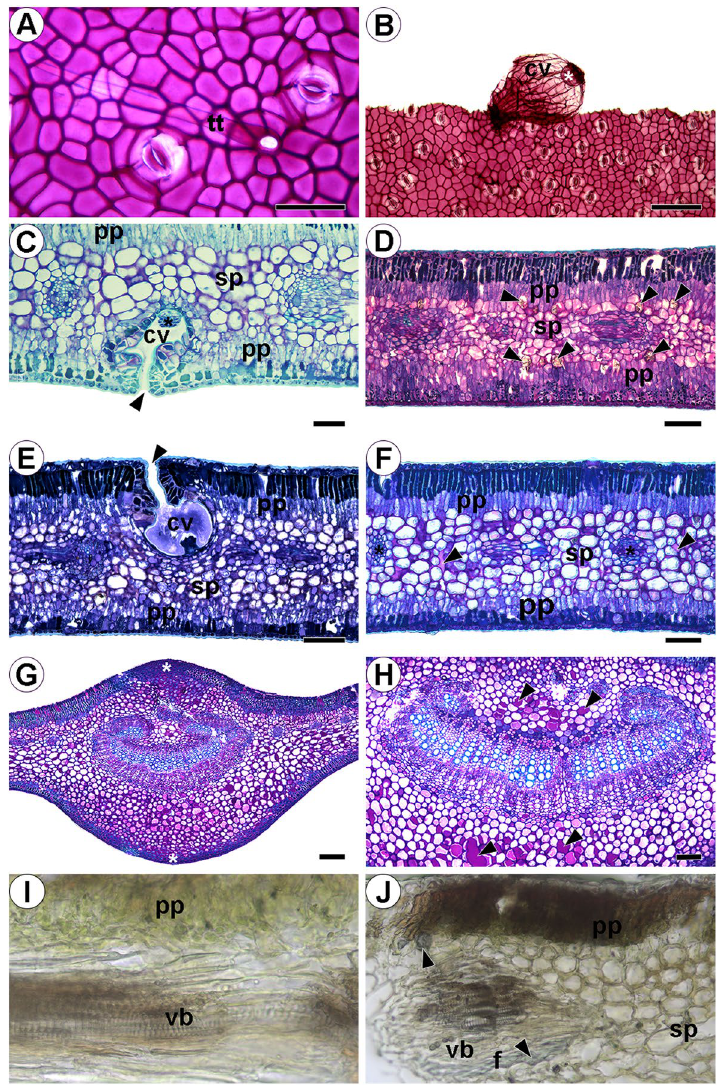
Figure 4. Light microscopy anatomical analysis of Laguncularia racemosa leaves collected in different mangroves in Rio de Janeiro (Brazil). ( A , B ) Frontal view of epidermis showing ordinary epidermal cells, stomata, unicellular non-glandular trichome (tt), and secretory cavity (cv) after removal of mesophyll with a salt secretory trichome at the bottom (*). ( C ) Cross section showing cavity (cv) on the abaxial epidermal surface where the salt secretory trichome (*) is located, with opening to external environment (black arrowhead), palisade parenchyma (pp) and spongy parenchyma (sp). ( D ) Leaf from Coroa Grande (CG): (pp) and (sp), crystal idioblasts with druses (black arrowheads). ( E ) Leaf from Pedra de Guaratiba (PG): adaxial secretory cavity (cv) with pore (black arrowheads). ( F ) Leaf from Marambaia (M): (pp), (sp), vascular bundles (vb); black arrowheads point to mucilage in spongy parenchyma. ( G ) Midvein cross section showing cortical and medullary parenchyma storing phenolic compounds (*). ( H ) Main vascular bundle evidencing phenolic idioblasts and mucilage (black arrowheads). ( I ) Cross section taken from a plant growing in M and exposed to Zincon. ( J ) Cross section taken from a plant growing in CG and exposed to Zincon, evidencing Zn in fibers and idioblasts with druse crystals. ( A , E ) CG mangrove; ( B , F , H ) M mangrove and ( D , G ) PG mangrove. A , B = 500 μm, C , G = 20 μm, D , E , F , H , J = 100 μm, I = 50